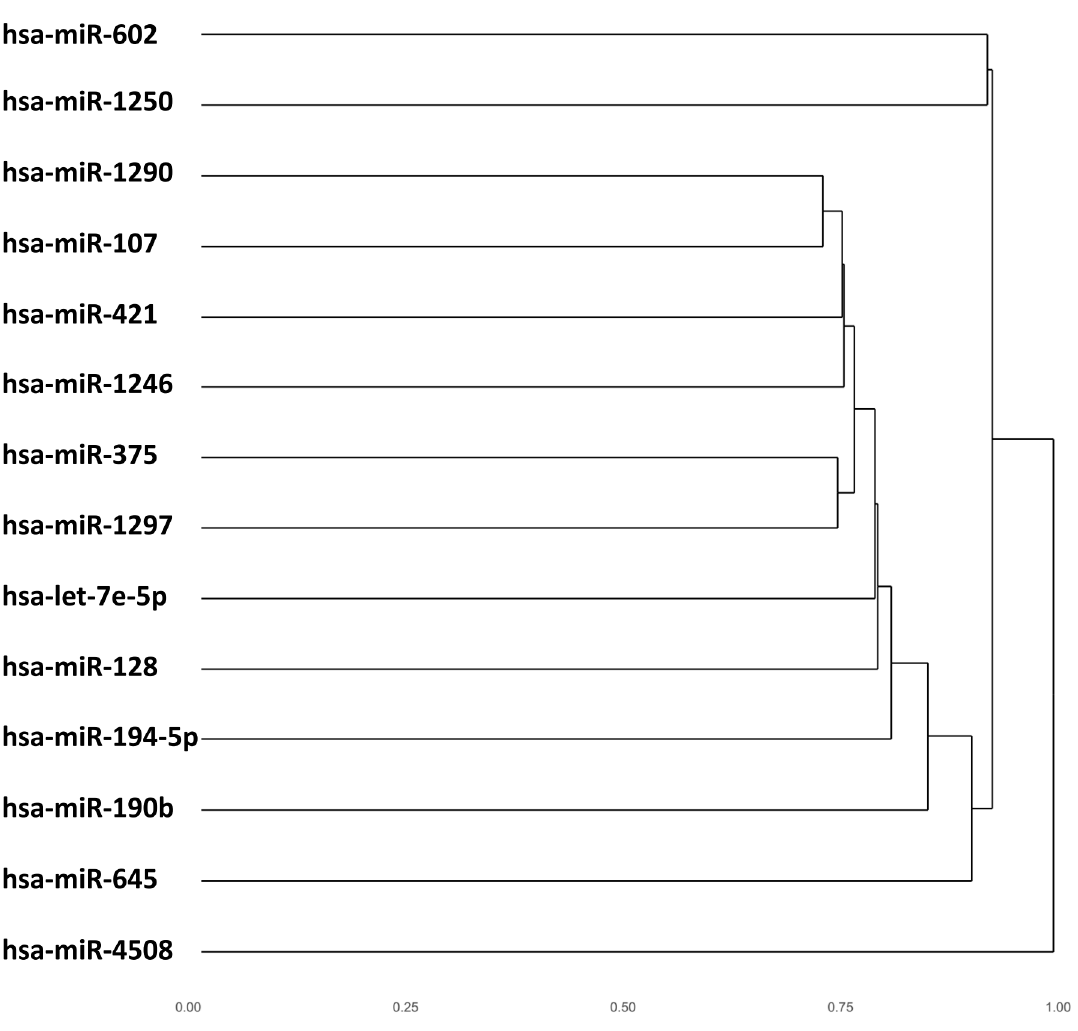
Figure 4. miRmapper output: dendrogram. The cluster is based on the similarity of the miRNAs’ Jaccard index values to each other.